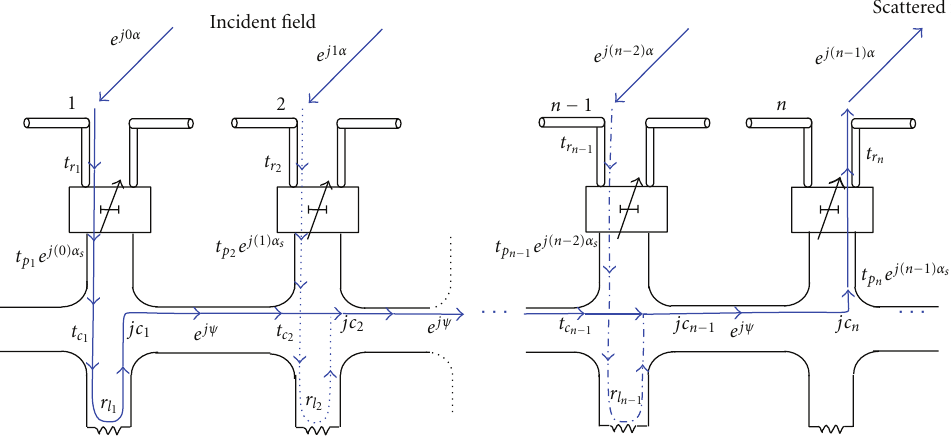
Figure 9: Path of the signal traveling towards the n th element from the previous ( n − 1)